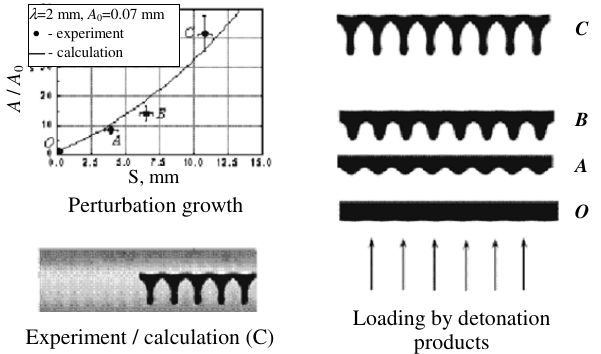
Fig. 2. Numerical simulation of perturbation growth in copper sample.